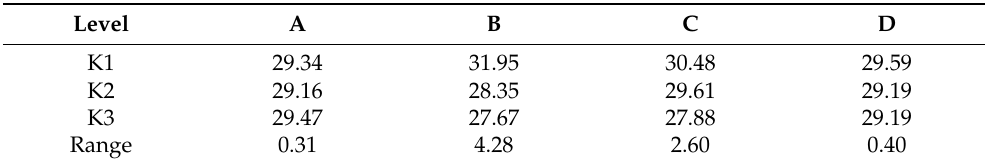
27.027.528.028.529.029.5